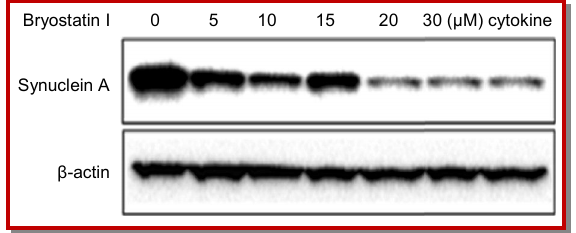
Figure 1: Inhibition of synuclein-A expression by bryostatin I treatment in H3922 breast cancer cells in a concentration de- pendent manner. Cytokine oncostatin M also inhibits the ex- pression of synuclein-A in H3922 cells. The cells were treated with 5, 10, 20, 25 and 30 µM concentrations of bryostatin I and 0.5 µM concentration of Cytokine oncostatin M for 48 hours and then examined by Western blot assay